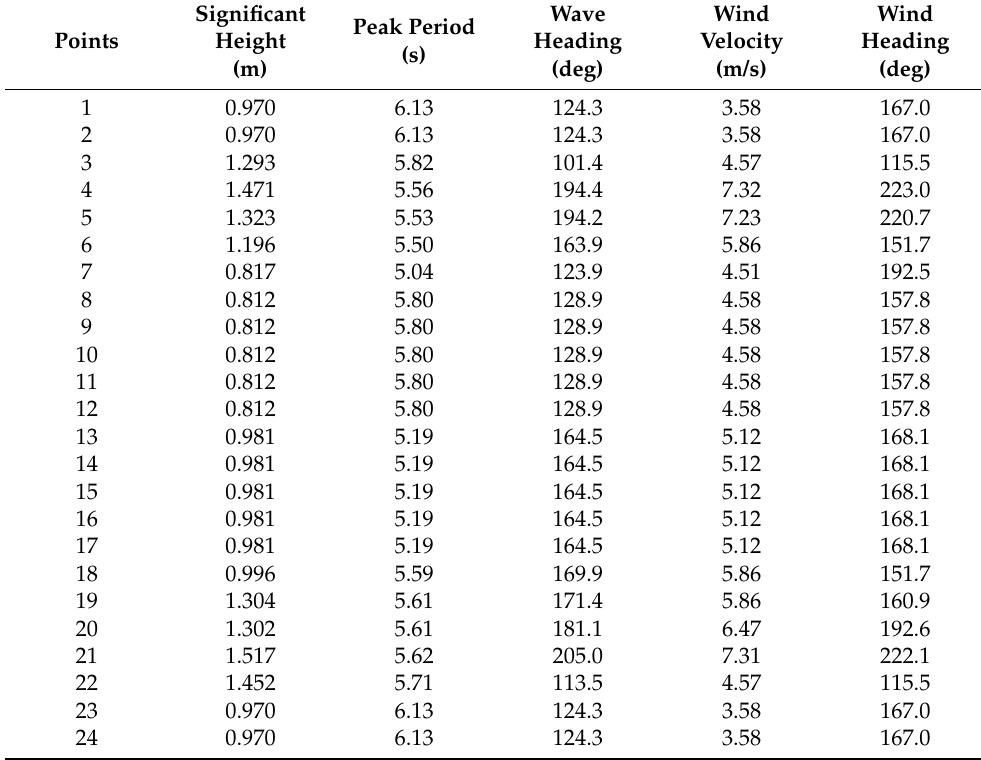
Table A5. Sea state per route point in September to November